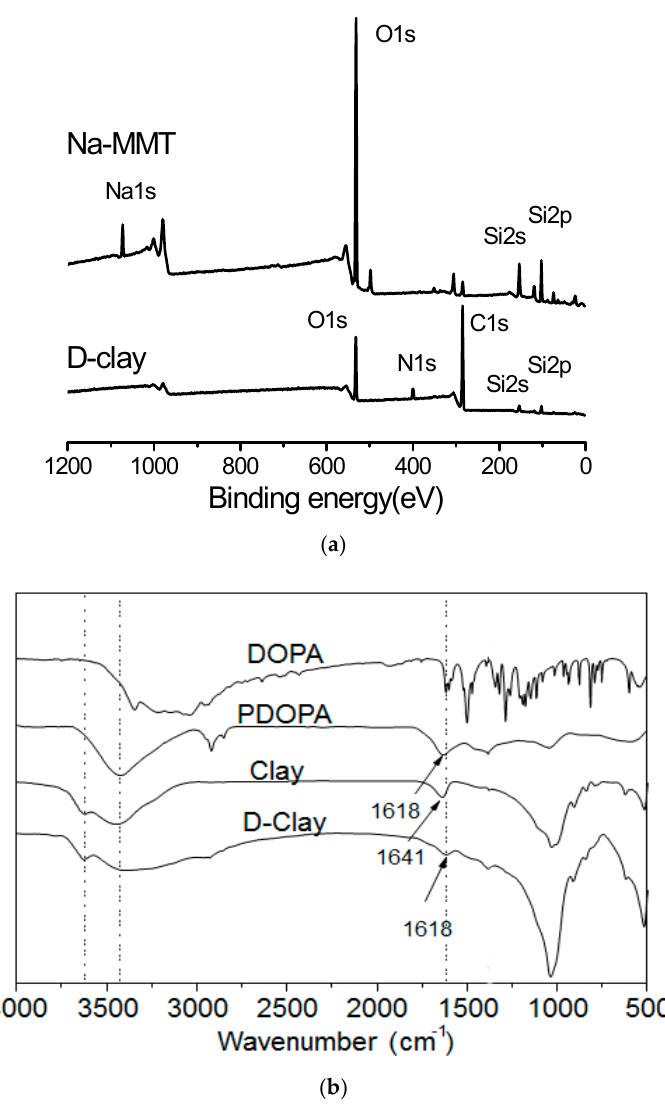
Figure 1. ( a ) XPS spectra of MMT clay and D-clay; and ( b ) FTIR spectra of MMT clay, D-clay, DOPA and PDOPA.